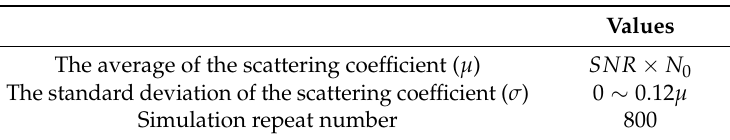
Table 3. The simulation parameters in Figure 6.